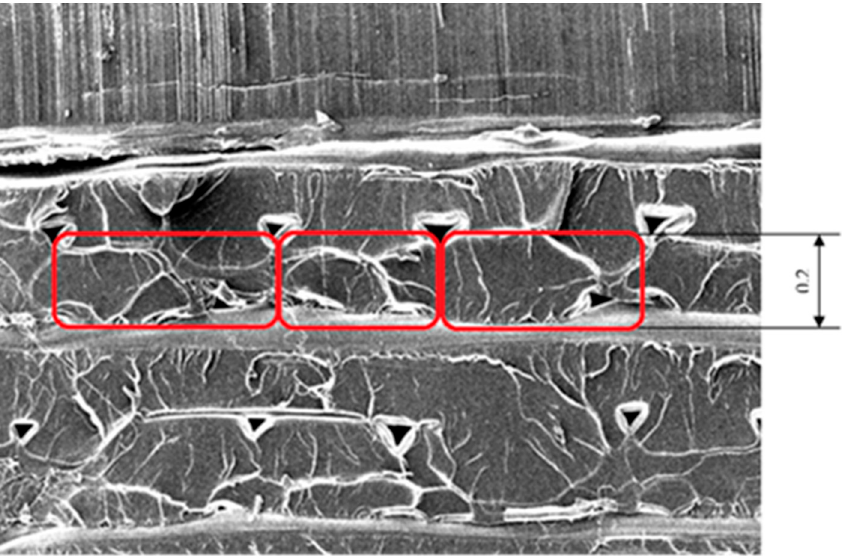
Figure 3. Layer thickness of a specimen of 0.2 mm, produced by a 0.4 mm nozzle